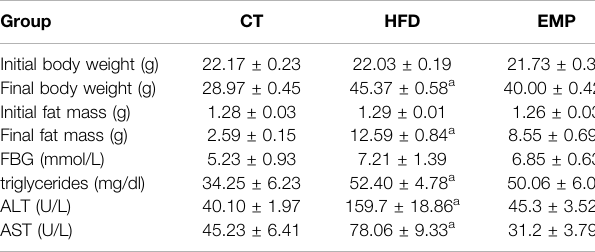
TABLE 2 | Biometric and blood parameters of rats in the studied